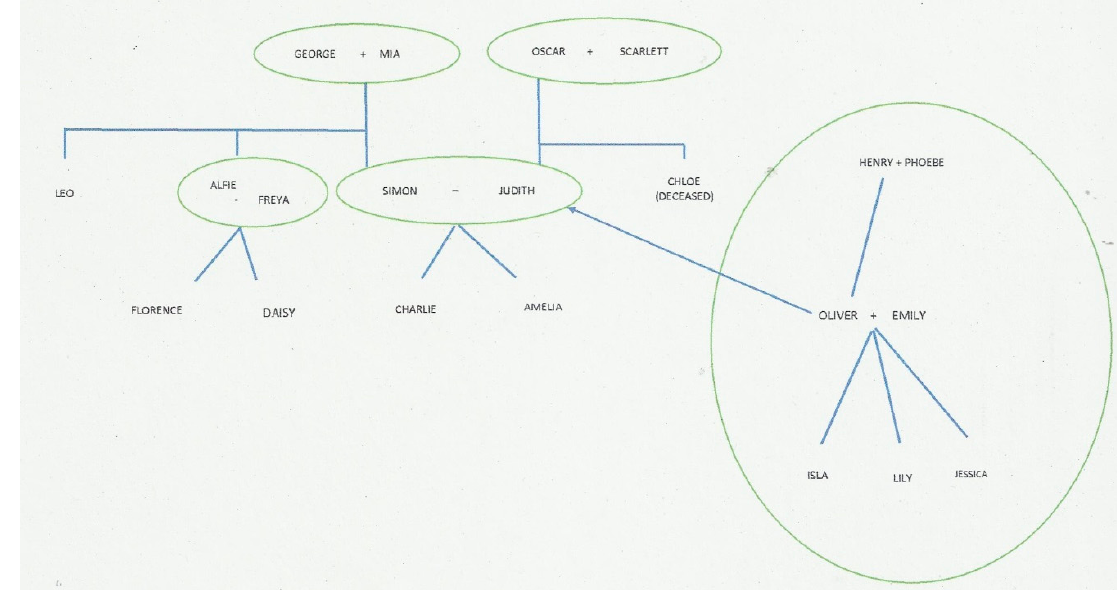
Figure 2. Judith’s family map. Genealogy 2018 , 2 , x FOR PEER REVIEW